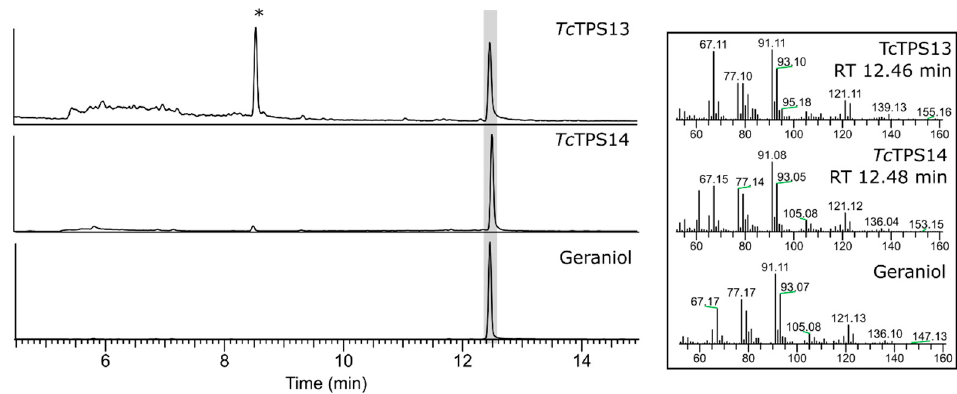
Figure 3. GC-MS analysis of the enzymatic products of Tc TPS13 and Tc TPS14 and comparison with the geraniol standard.